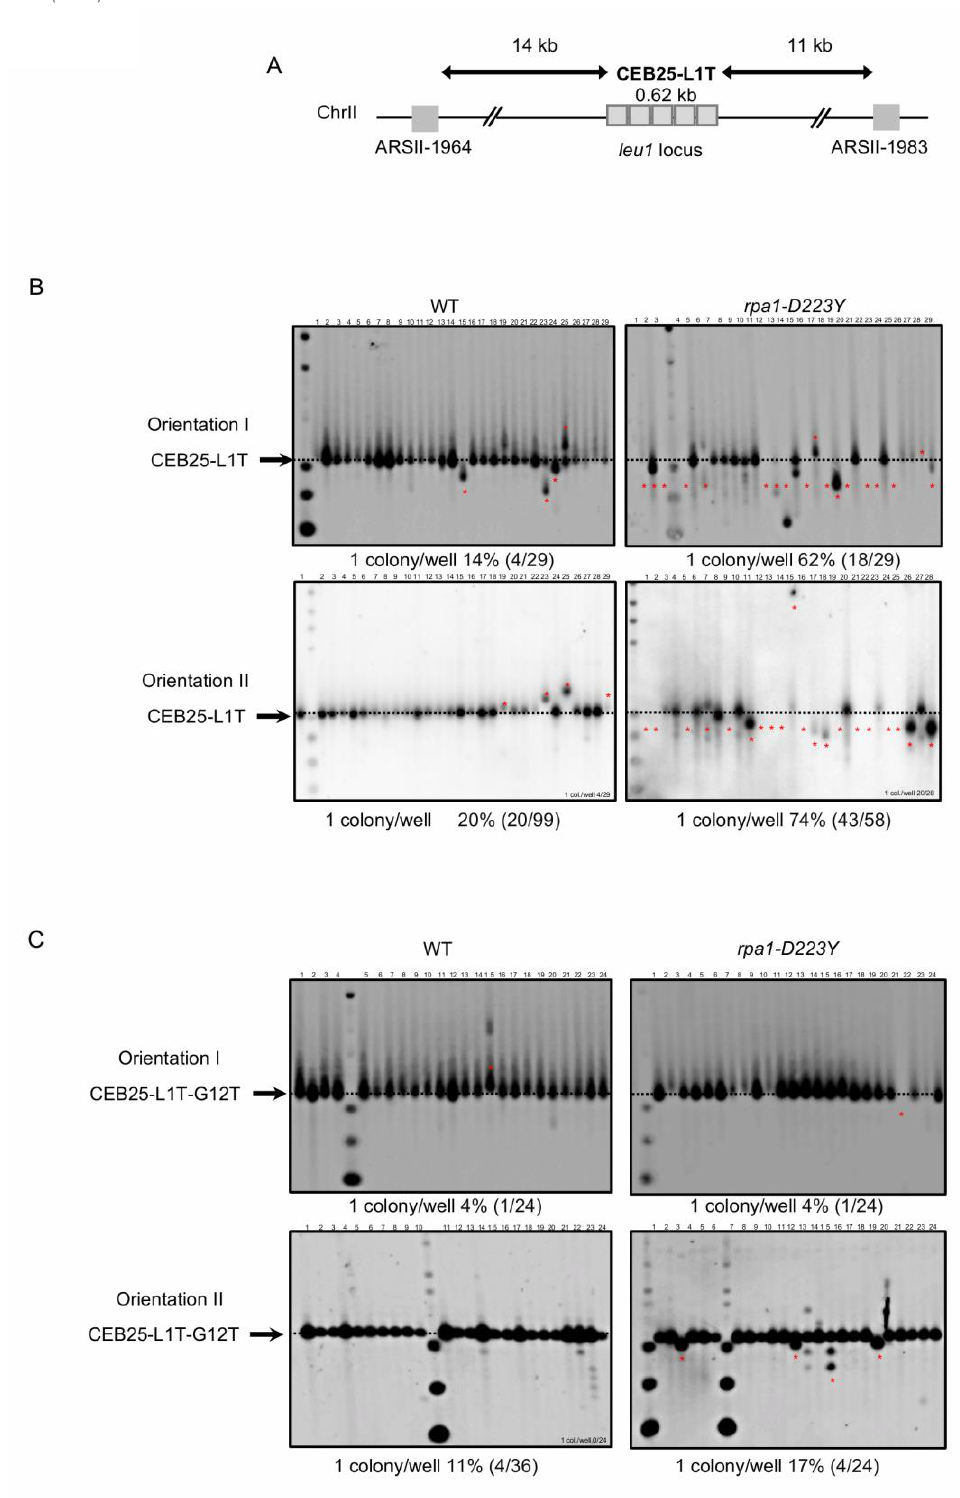
FIGURE 7: RPA is required to stabilize CEB25-L1T in fission yeast. (A) Map of the CEB25-L1T insertion within chromosome II at 14 kb from the ARS-II- 1964 and at 11 kb from the ARS-II-1983. (B) Genomic DNA from cells containing CEB25-L1T in orientation 1 and 2 was digested by Pvu II and southern blotted. Membranes were hybridized with CEB25 probe. (C) Genomic DNA from cells containing mutated CEB25-L1T-G12T in orientation 1 and 2 was digested by Pvu II and southern blotted. Membranes were hybridized with a CEB25-L1T probe. The number of colonies analysed per well, the percent- age of rearrangement frequencies, and the total number of colonies are indicated. Red stars mark unstable events. We calculated the frequency of instability by monitoring the size and the intensity of the CEB25. We considered that CEB25 was unstable when the intensity of the short or high band was superior to the one of the parental band or when the band disappears. The number of colonies analysed per well, the percentage of rearrange- ment frequencies, and the total numbers of colonies are indicated in Table